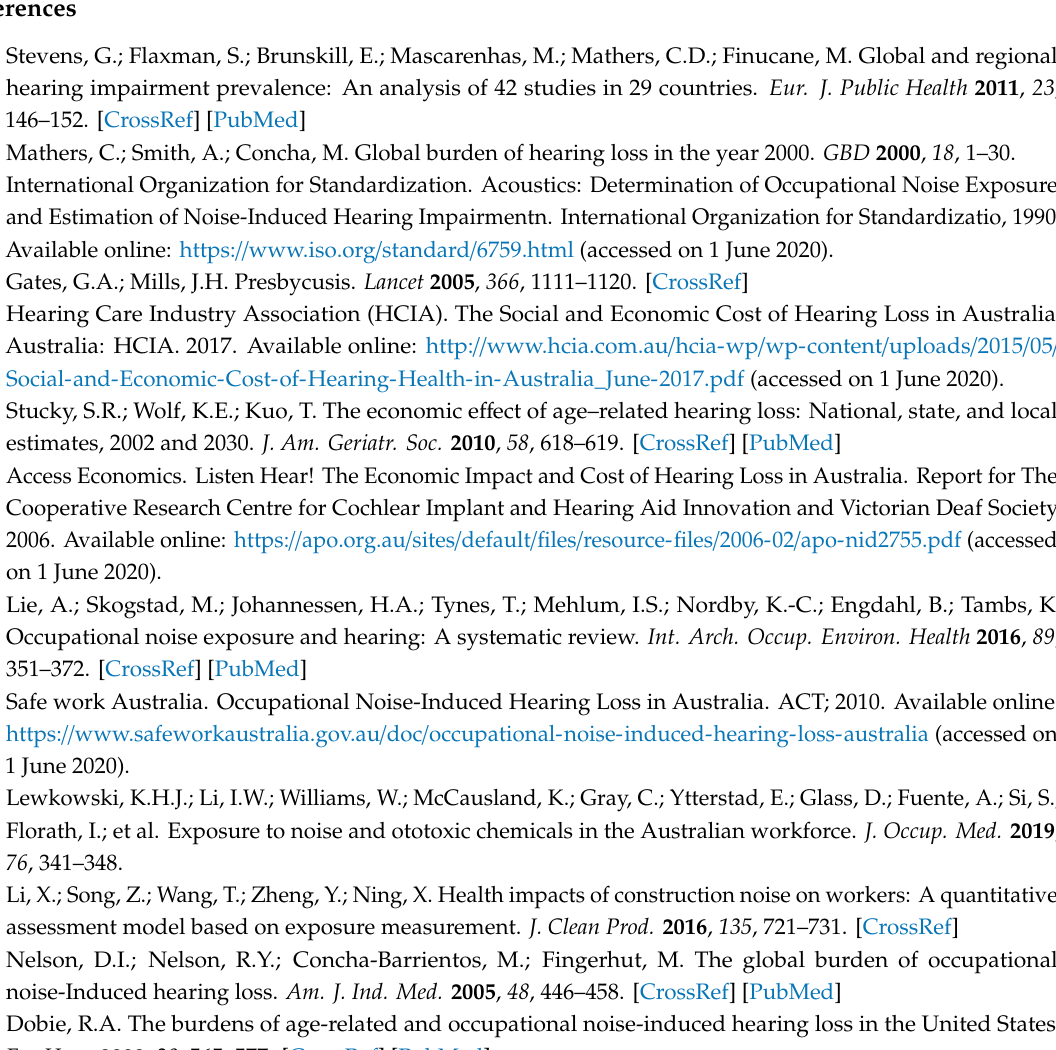
Table S1: Quantifying the risks of hearing loss resulting from noise exposure via simulation. Table S2: Simulated Prevalence of Age-Related Hearing Loss by Gender and Age Groups; Table S3: Prevalence Ratios for Hearing Loss in Relation to Noise Exposure at 85–89 dB for 10 Years versus Age-Related Hearing Loss; Table S4: Prevalence Ratios for Hearing Loss in Relation to Noise Exposure at 90–100 dB for 10 Years versus Age-Related Hearing Loss; Table S5: Occupational noise exposure in Australian working population; Table S6: Prevalence of Age-related hearing loss and Prevalence ratios of noise-induced hearing loss; Table S7: QALY of healthy Australians by age and gender; Table S8: Australian workforce participation